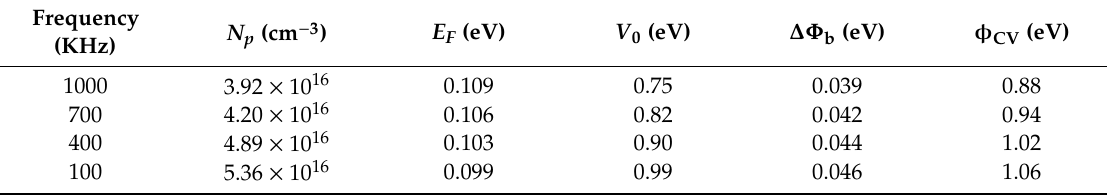
Table 2. The parameters calculated from 1 / C 2 – V for characteristics of the Al / SiO 2 / p -GaN MOS Schottky diode between 100 kHz and 1 MHz at the room